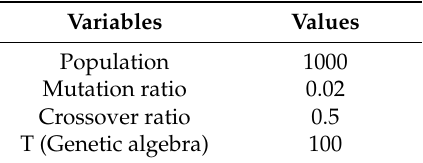
Table 2. Parameters related to the GA-based optimization algorithm.